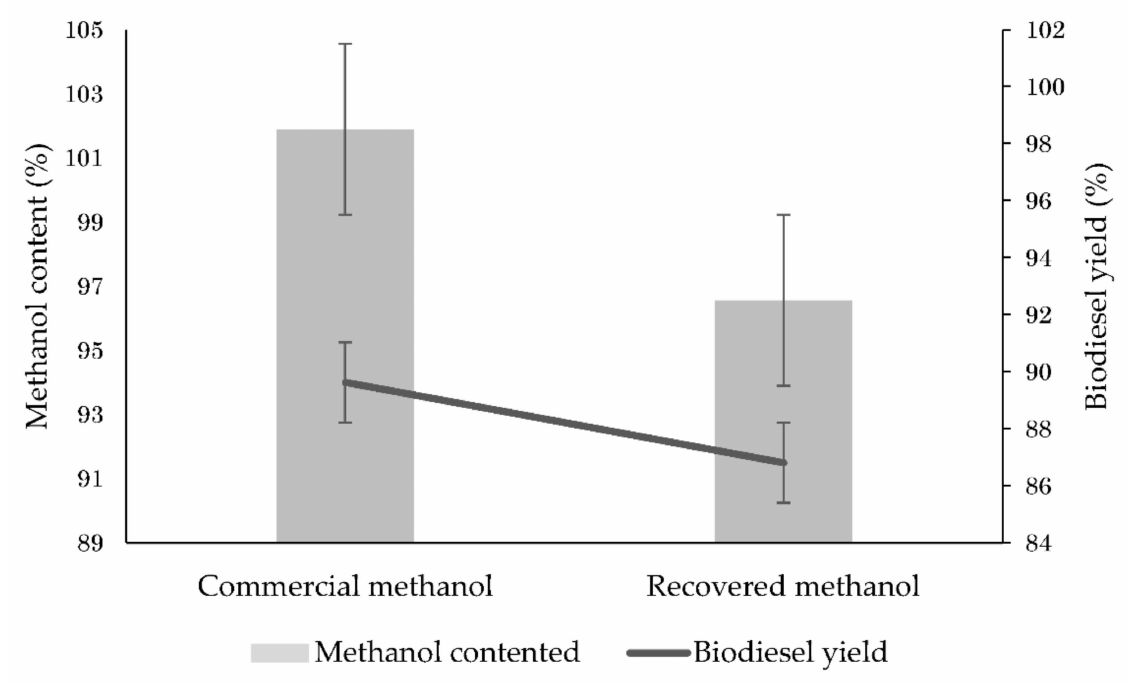
Figure 8. Methanol content and biodiesel yield of commercial methanol and recovered